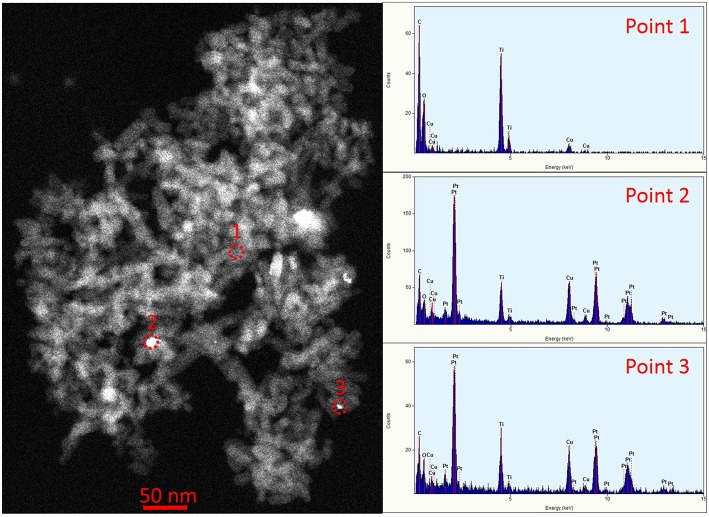
STEM image of TNT-500-Pt. EDS spectra correspond to points 1, 2, 3, in the image, respectively. The Cu peak is caused by the grid, whereas the C peak is caused by the grid and the sample.